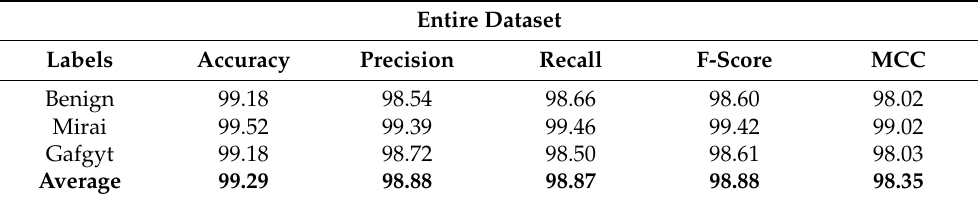
Table 2. Result analysis for BND-BMOML algorithm with distinct class labels using entire